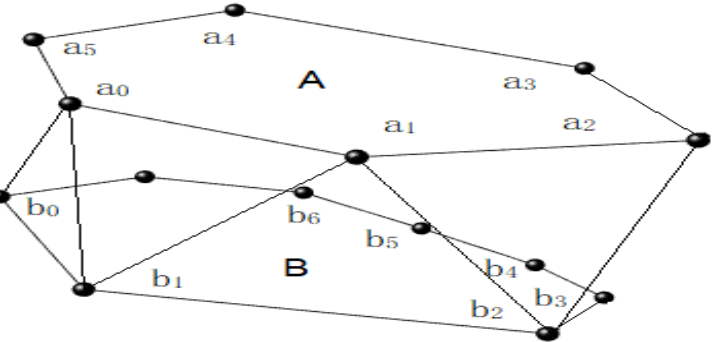
Figure 2. Schematic modeling of parallel contour lines.